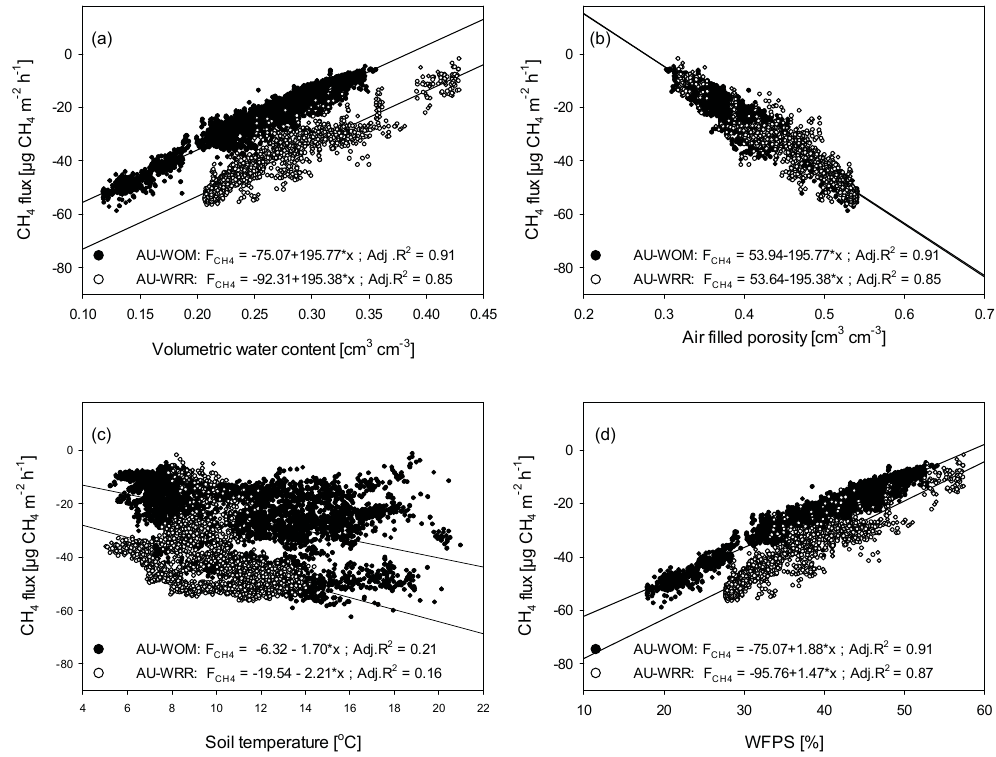
Figure 4. Relationships between soil volumetric water content and soil CH 4 flux (a) , soil air-filled porosity and soil CH 4 flux (b) , soil temperature and soil CH 4 flux (c) and soil water-filled pore space (WFPS) and soil CH 4 flux (d) for each chamber cycle at a mixed Eucalyptus obliqua forest stand, Wombat State Forest, Victoria (black circles, AU-WOM) and at a mixed E. obliqua and E. regnans forest stand, Warra LTER, Tasmania, Australia (white circles, AU-WRR). Lines symbolise significant linear regressions between the parameters (regression parameters are listed in Table